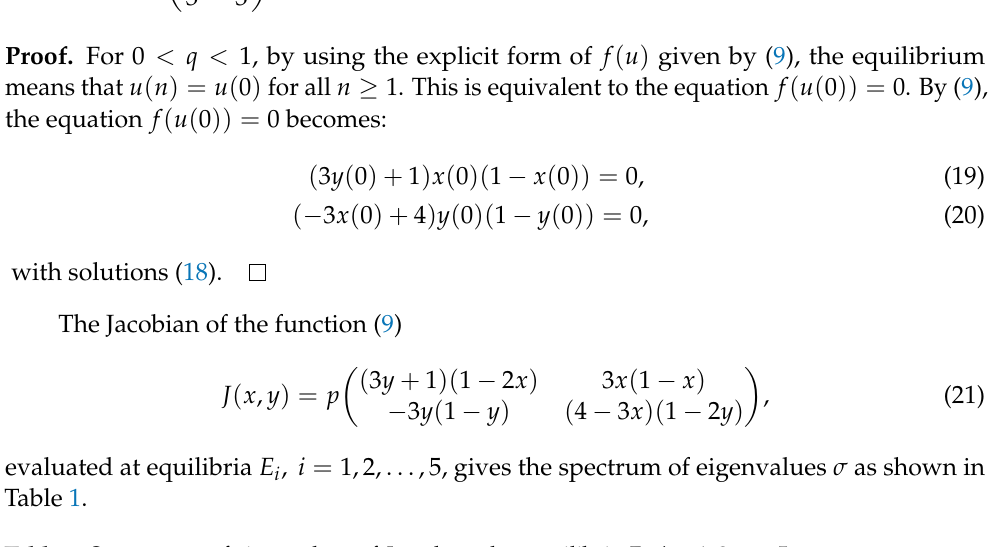
Table 1. Spectrum σ of eigenvalues of J evaluated at equilibria E i , i = 1,2, . . . ,5. E σ ( J ) E 1 ( − 4 p